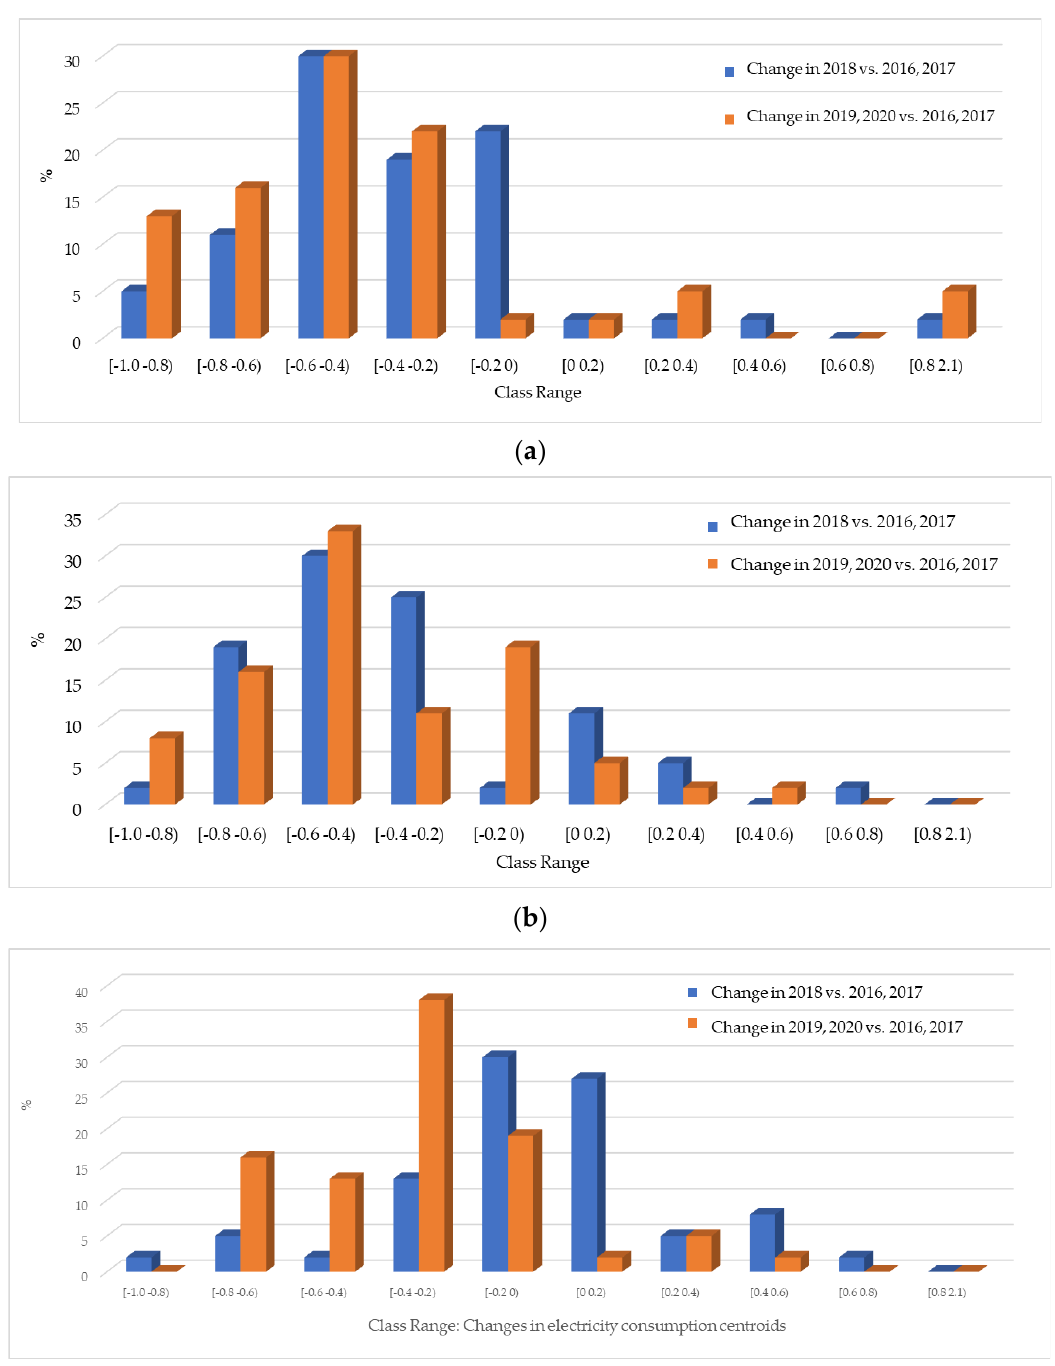
Figure 5. Histogram plots of the distribution in relative changes in electricity consumption compared to the first time interval (i.e., 2016–2017) in per unit values: ( a ) low consumption profile; ( b ) medium consumption profile; ( c ) high consumption profile.